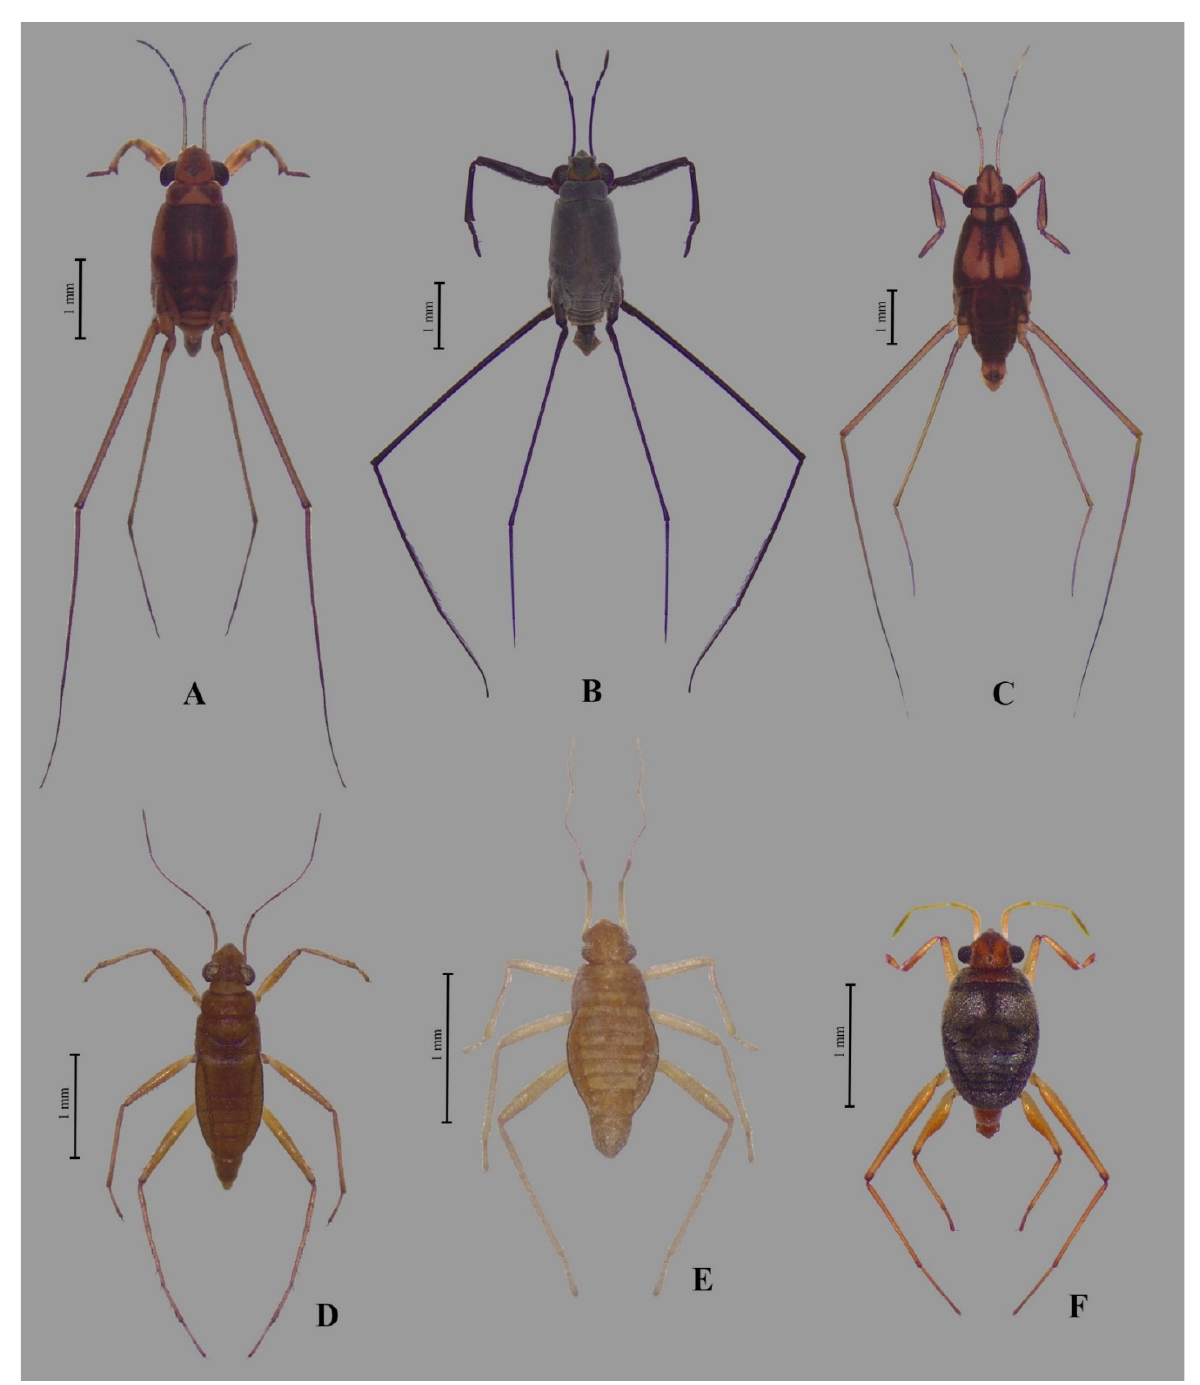
Figure 4. Habitus of a male of each genus collected for the 25 mangroves in Thailand: ( A ) Asclepios annandalei, ( B ) Halobates dianae, ( C ) Rheumatometroides insularis insularis, ( D ) Mesovelia vittigera, ( E ) Nereivelia murphyi, and ( F ) Xenobates mandai.